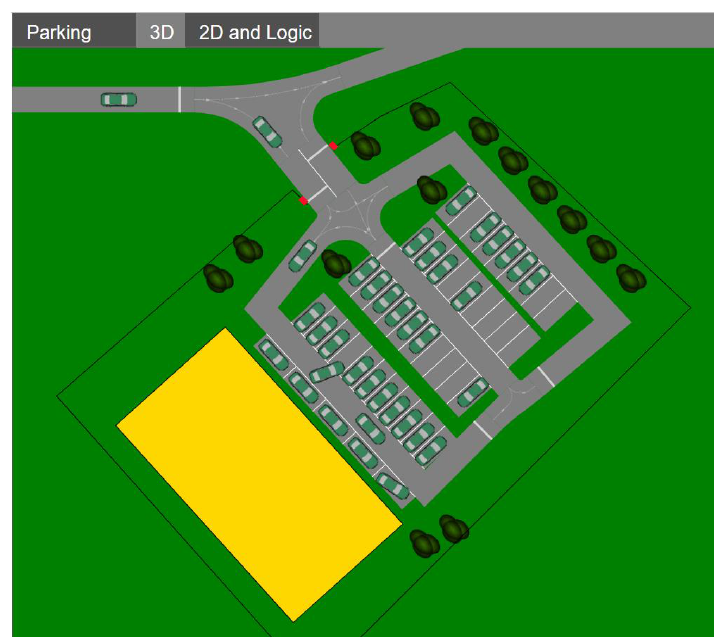
Figure 9. A 2D animation of the new model.